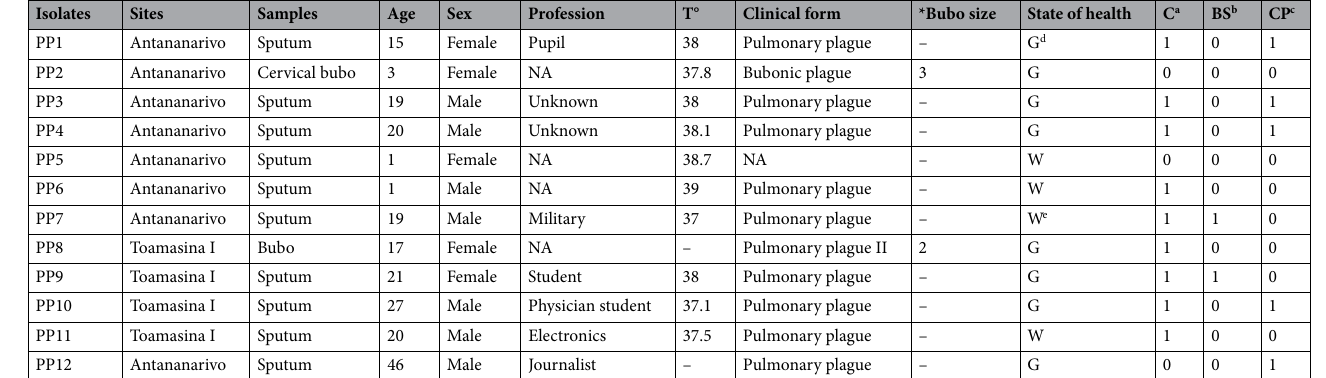
Table 1. Study population. C a cough, BS b bloody sputum, CP c chest pain, G d Good, W e Weak, NA not available, *3 size of a lychee core, 2 size of a